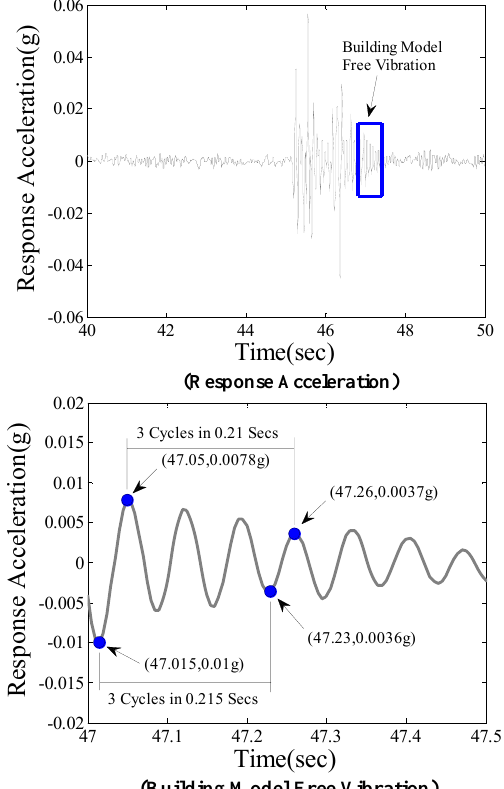
(Building Model Free Vibration) (Response Acceleration) Figure 7. Dynamic characterization of building model under 0.04g input excitation. From left to right: model response acceleration and free vibration time history processed for the estimation of building vibration period and elastic damping coefficient.